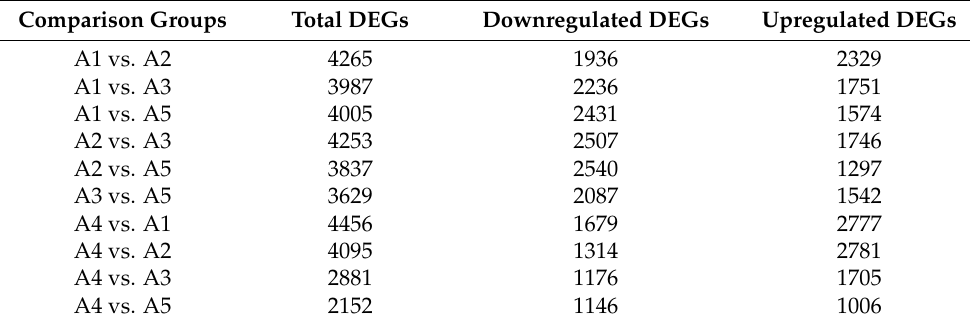
Table 2. The number of DEGs identified in the pairwise comparisons. Comparison